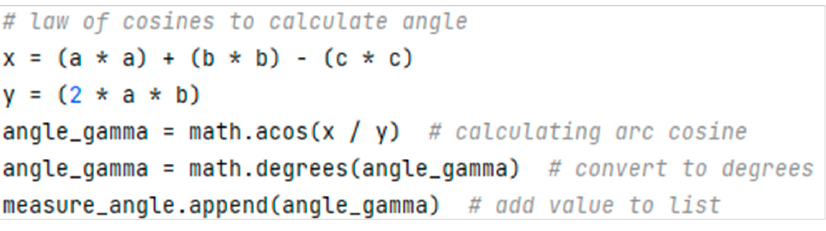
Figure 8. Calculation of the bending angle using the Cosine Law.